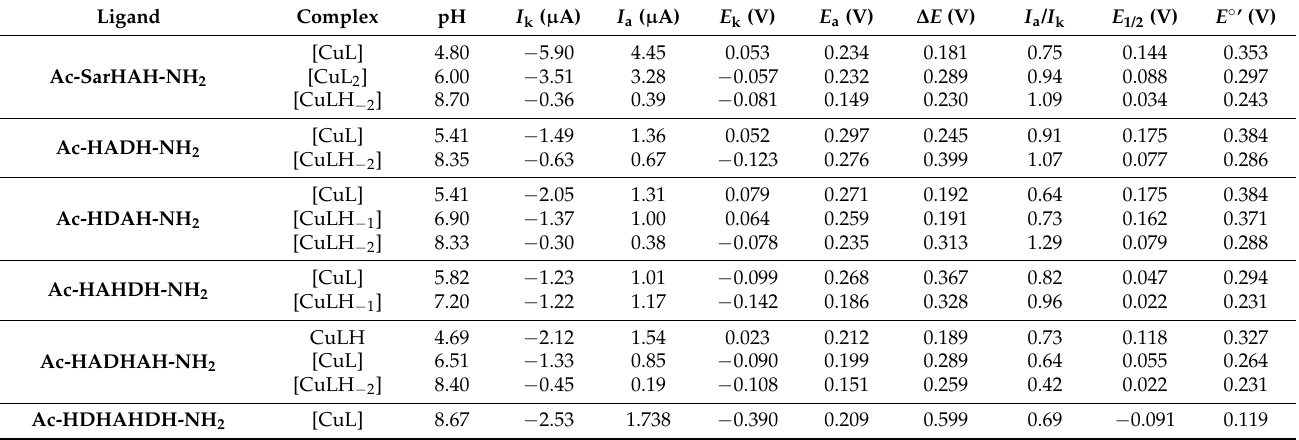
Table A3. Parameters of the voltammetric measurements and the electrochemical data of the Cu(II)– multhistidine peptides complexes.